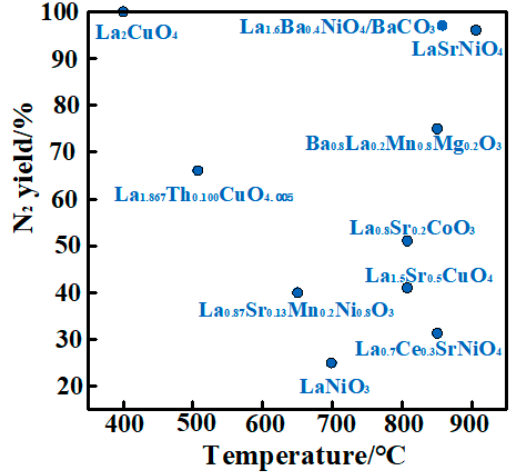
Figure 5. NO decomposition catalytic activity of some LaMO 3 -based perovskite.